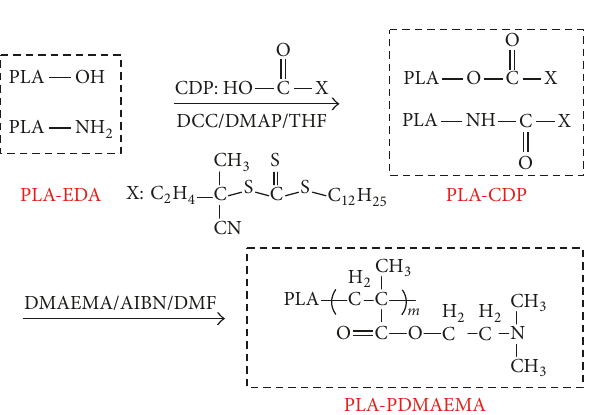
Figure 5: Schematic illustration for the preparation of PLA- PDMAEMA block copolymers via RAFT